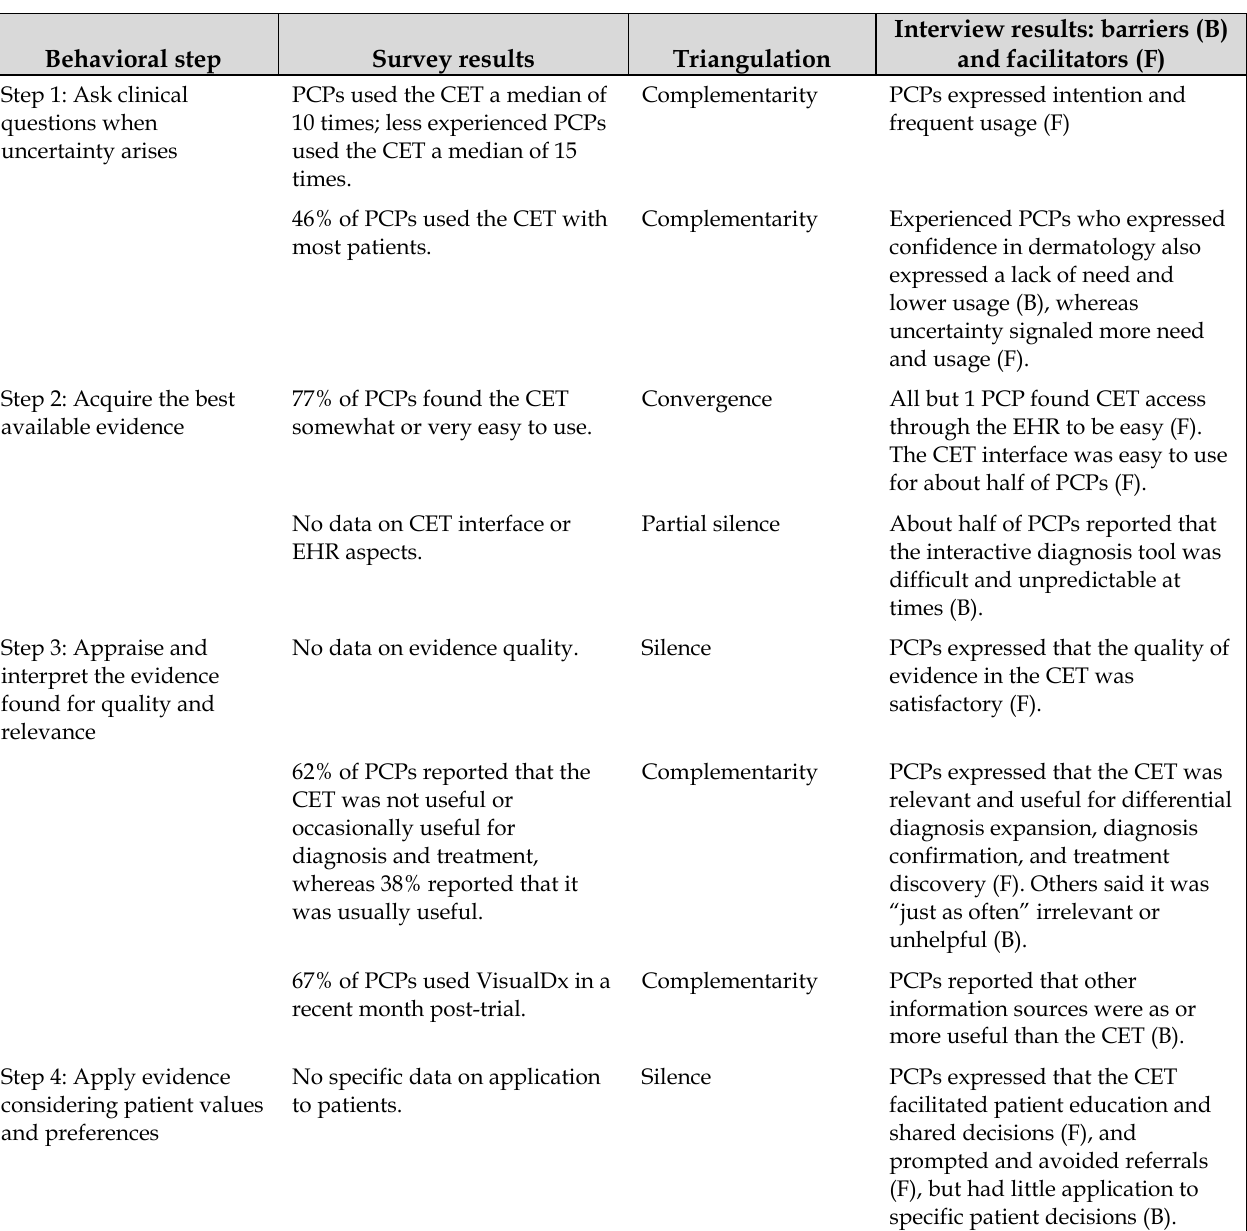
Table 4 Integration of mixed